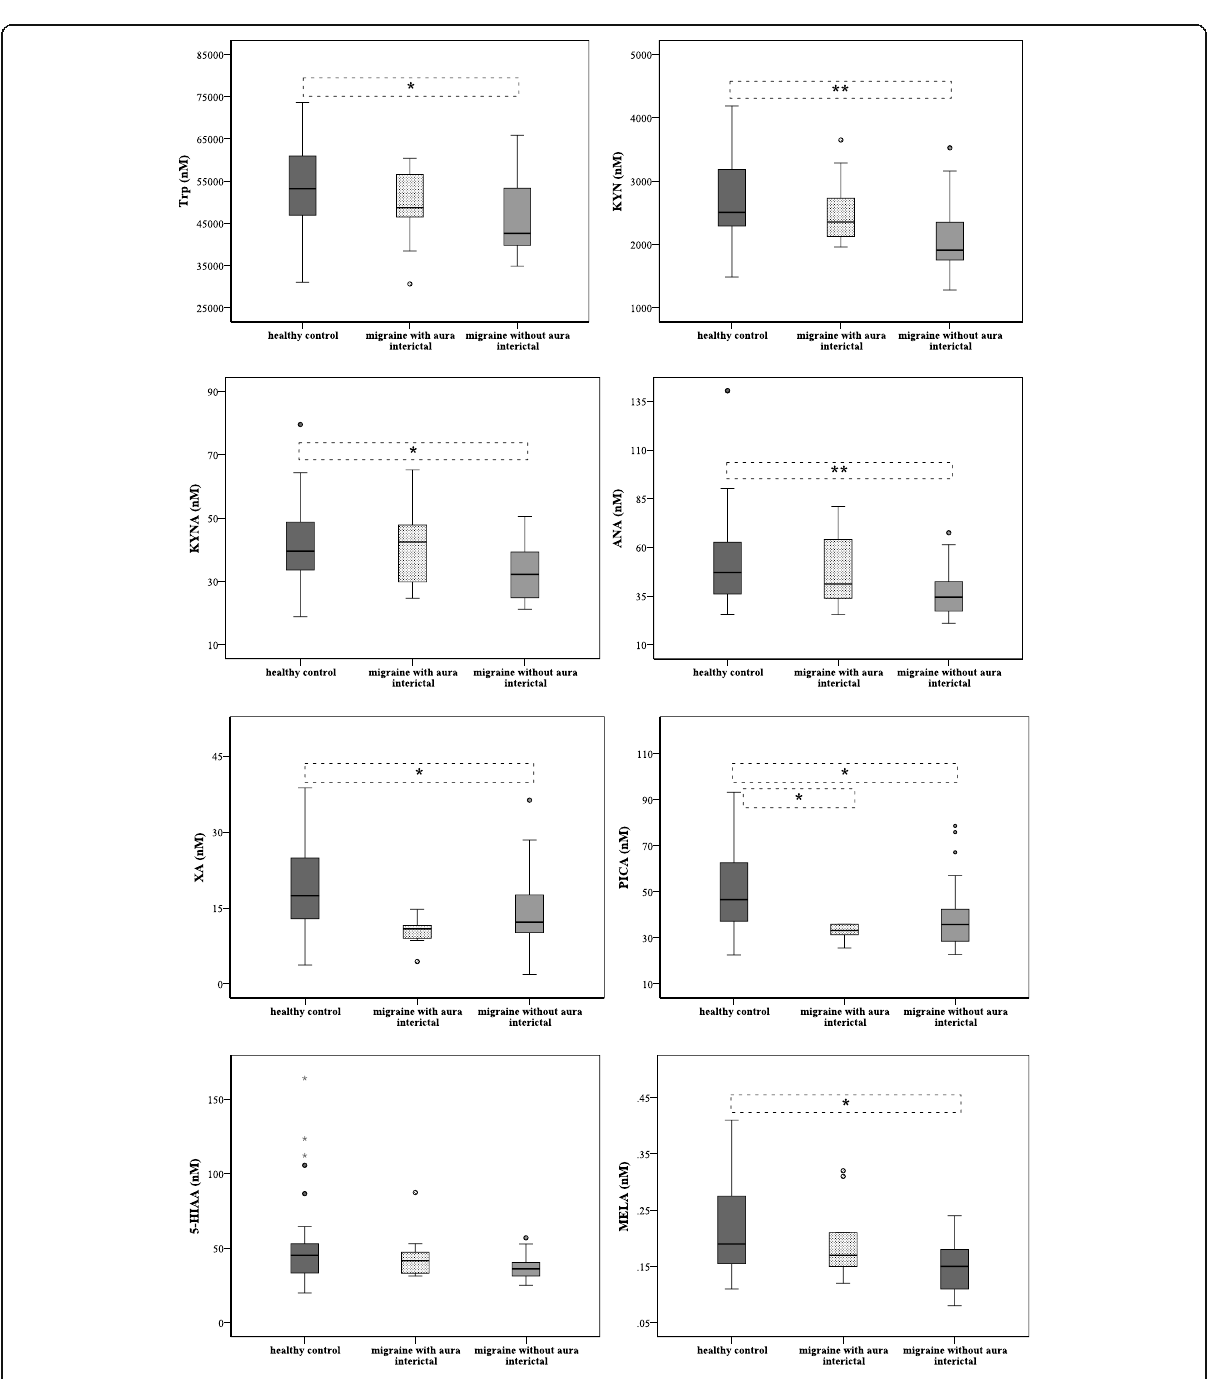
Fig. 2 Differences in plasma levels of Trp, KYN, KYNA, ANA, XA, PICA, 5-HIAA and MELA between patients with aura (MWA) and without aura (MWoA) (median, interquartile range, minimum, maximum values and outliers were presented in this figure). Sample sizes in groups: healthy control (n = 34), interictal phase of MWA ( n = 11), interictal phase of MWoA ( n = 36). Sample sizes in case of MELA: healthy control (n = 30), interictal phase of MWA ( n = 9), interictal phase of MWoA ( n = 28). Significance levels: * p < 0.05, ** p < 0.01. Trp: Tryptophan, KYN: L-kynurenine, KYNA: Kynurenic acid, ANA: Anthranilic acid, XA: Xanthurenic acid, PICA: Picolinic acid, 5-HIAA: 5-hydroxy-indoleaceticacid, MELA: